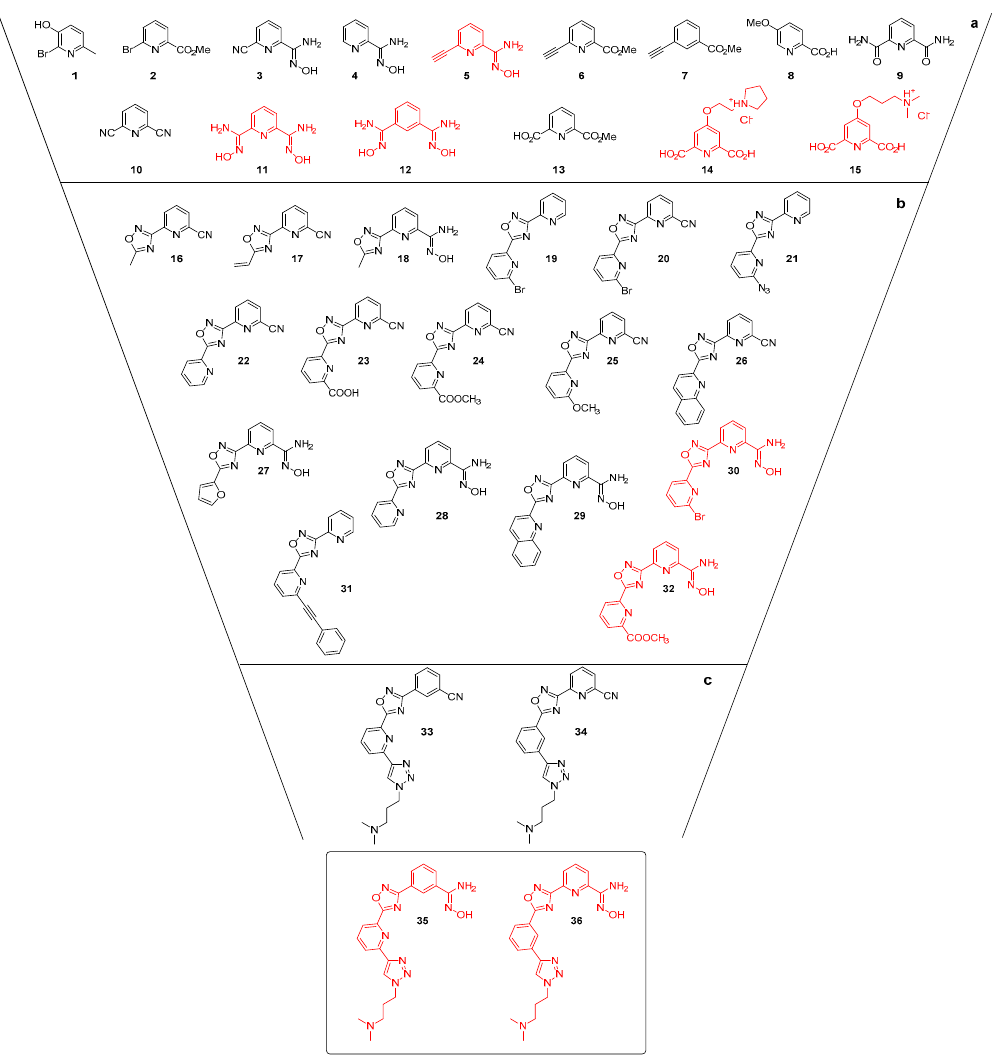
Figure 2. Fragment-based approach starting from ( a ) mono-aryl fragments, evolving trough ( b ) low level of complexity bi- and tri-aryl derivatives and ( c ) final tetra-heteroaryl hits. Table 1. Stabilization of LTR-III, hTel G4s and dsDNA (0.25 μ M) in the presence of 4000-fold excess of fragments (1 mM) vs. oligonucleotide, measured by FRET melting assay.